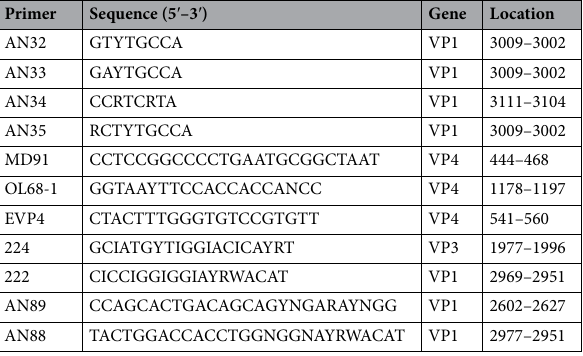
Table 3. Primers used for cDNA synthesis, PCR amplification, and